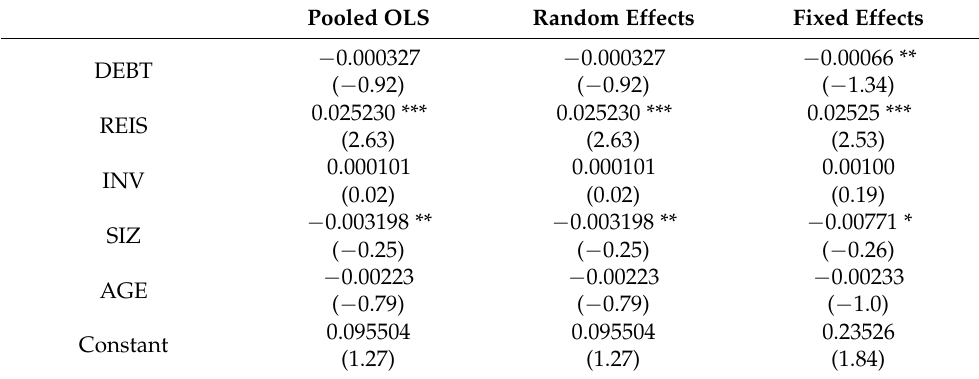
Table 6. Empirical Results when ROA is used a Measure in Panel